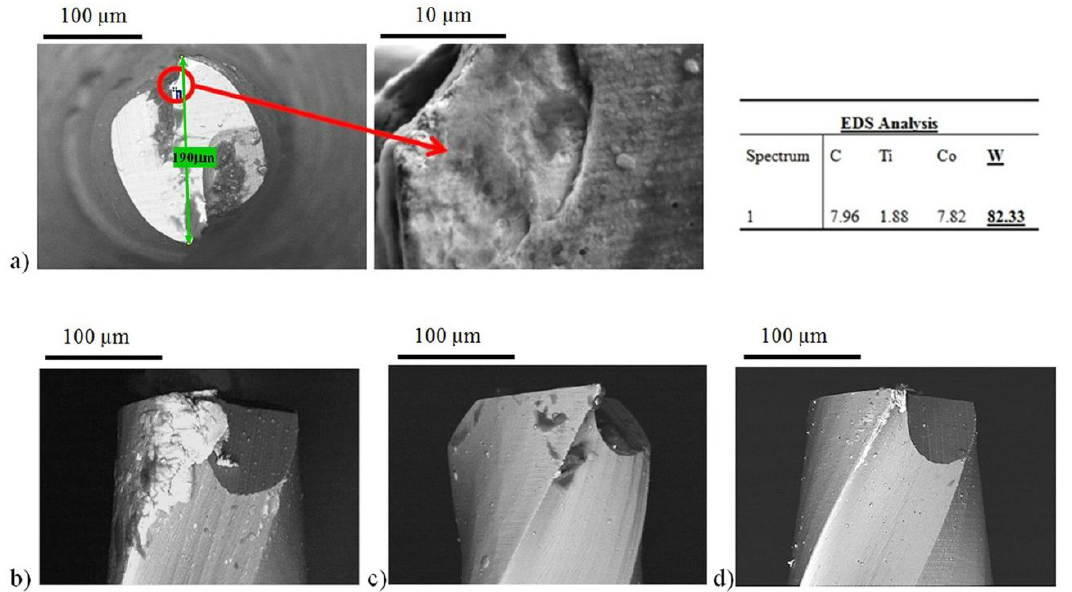
Figure 7. Scanning electron microscope (SEM) images of ( a ) coating delamination (fully equiaxed microstructure) with corresponding energy dispersive spectroscopy (EDS) analysis results; ( b ) built up edge (mill annealed microstructure); ( c ) tool condition after machining fully lamellar microstructure and ( d ) tool condition after machining bimodal